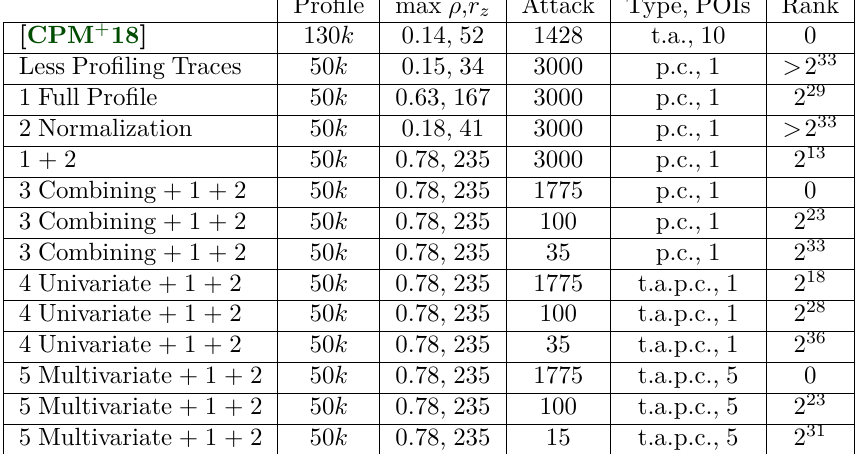
Table 7: Before exploring more challenging attacks, we show as reference the attack at 10 m in an anechoic chamber of Screaming Channels [CPM + 18]. To be fair, we apply our improvements (incrementally). We reduce the number of profiling traces and we move to profiled correlation with 1 POI (Less Profiling Traces). Correlation improves significantly when considering the nonlinear leak model (1 Full Profile) and the channel (2 Normalization). Combining the 16 bytes improves the attacks (3 Combining). Univariate template attacks (with pooled variance) are not better (4 Template). Multivariate templates attacks (with pooled covariance) are better when more POIs are available (5 Multivariate).